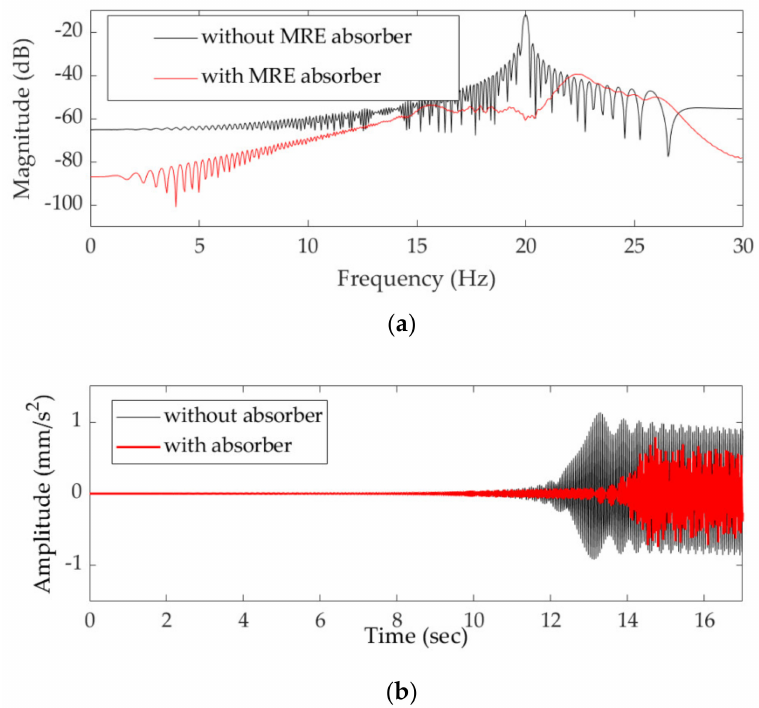
Figure 9. Numerical simulation results of adaptive tuned vibration absorber. ( a ) Frequency response, ( b ) Time response (acceleration).